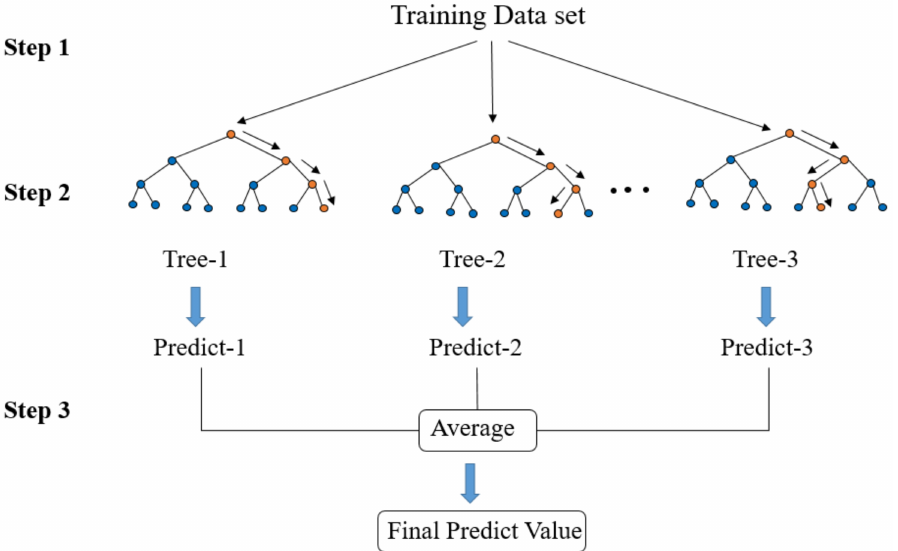
Figure 12. Schematic diagram of random forest structure.